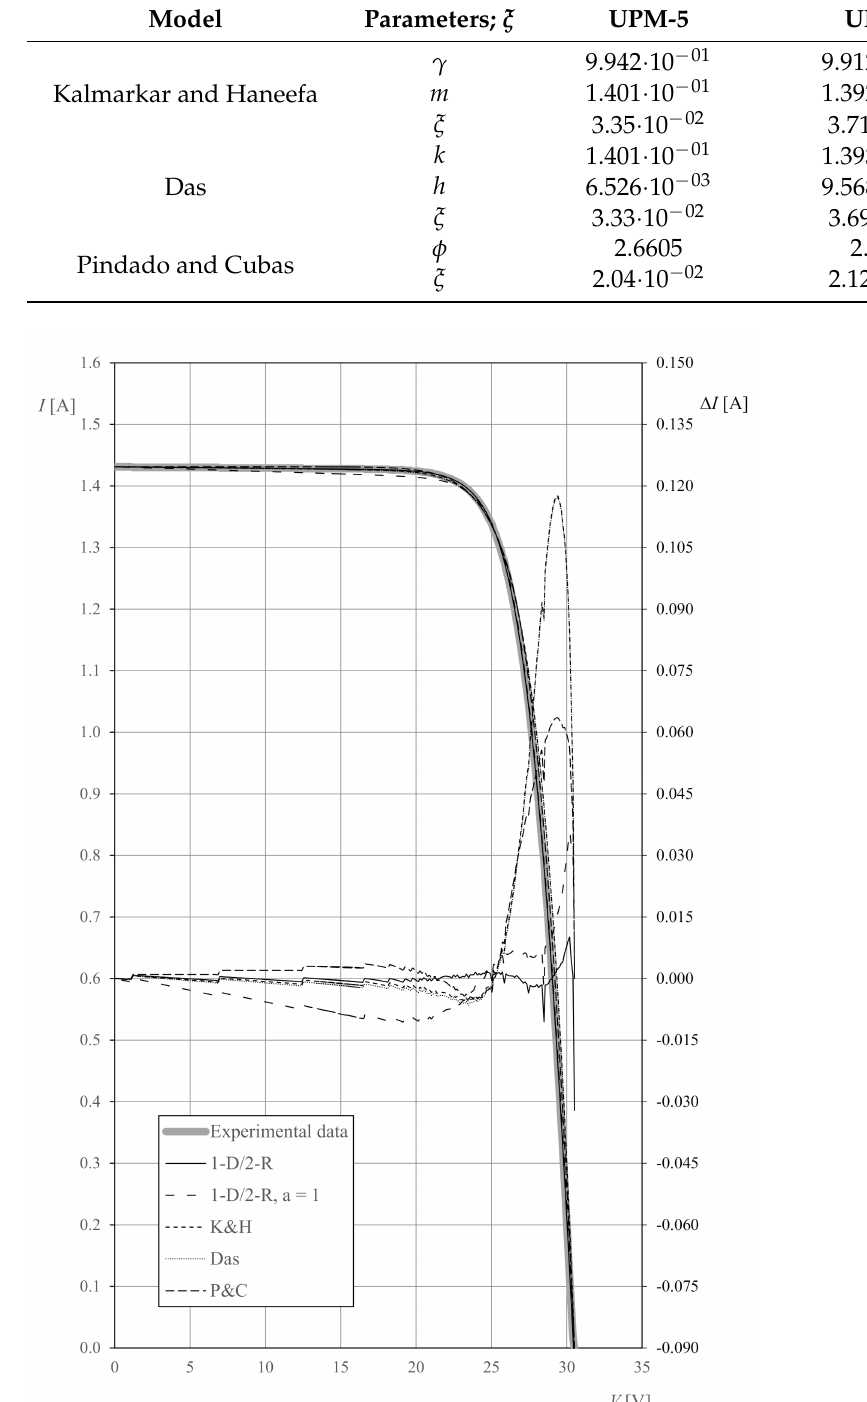
Table 7. Parameters for the explicit models proposed by Kalmarkar and Haneefa, Das and Pindado and Cubas, for the UPM-5 and UPM-6 solar panels of the UPMSat-1 satellite. ξ is the non-dimensional RMSE for the experimental data.